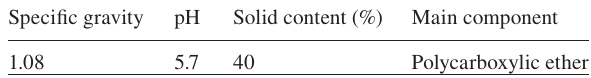
Table 5 Properties of chemical admixture.